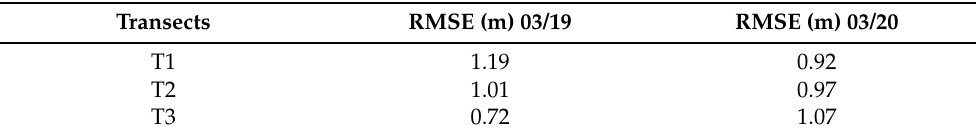
Table 1. Difference between satellite-based DEM and RTK-GPS survey (RMS error) for each cross- shore transect.